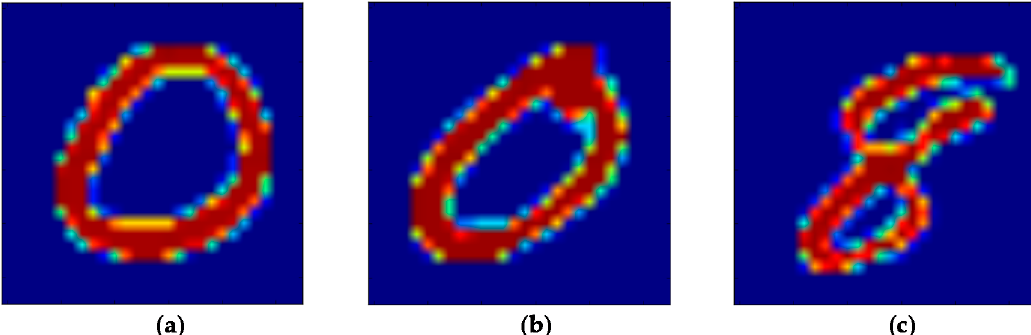
Figure 6. Images contained in different level three nodes. ( a ) An image of digit 0 from node lv3-434 . ( b ) An image of digit 0 from node lv3-3 . ( c ) An image of digit 8 from lv3-7 . Considering the Euclidean distance, ( b ) and ( c ) could be closer than ( a ) and ( b ).